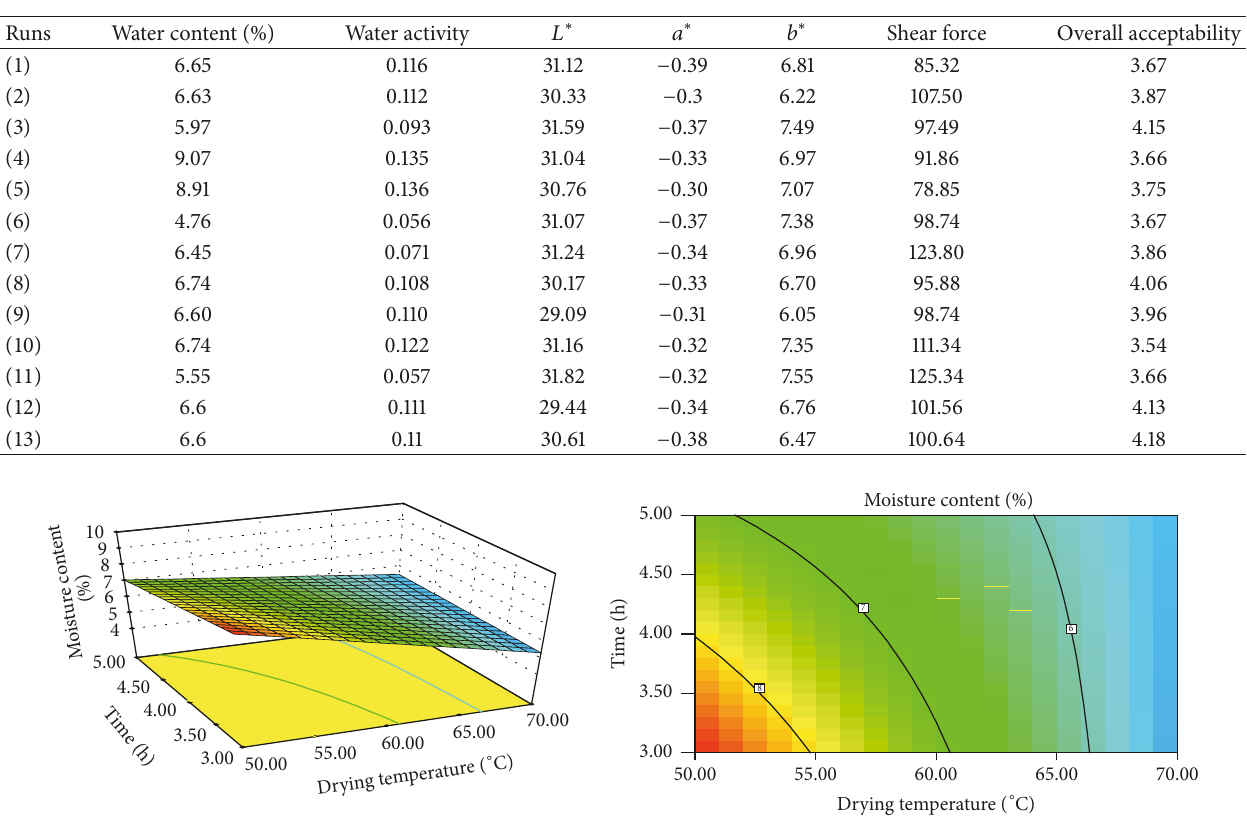
Table 3: Experimental values of response variables for response surface design.